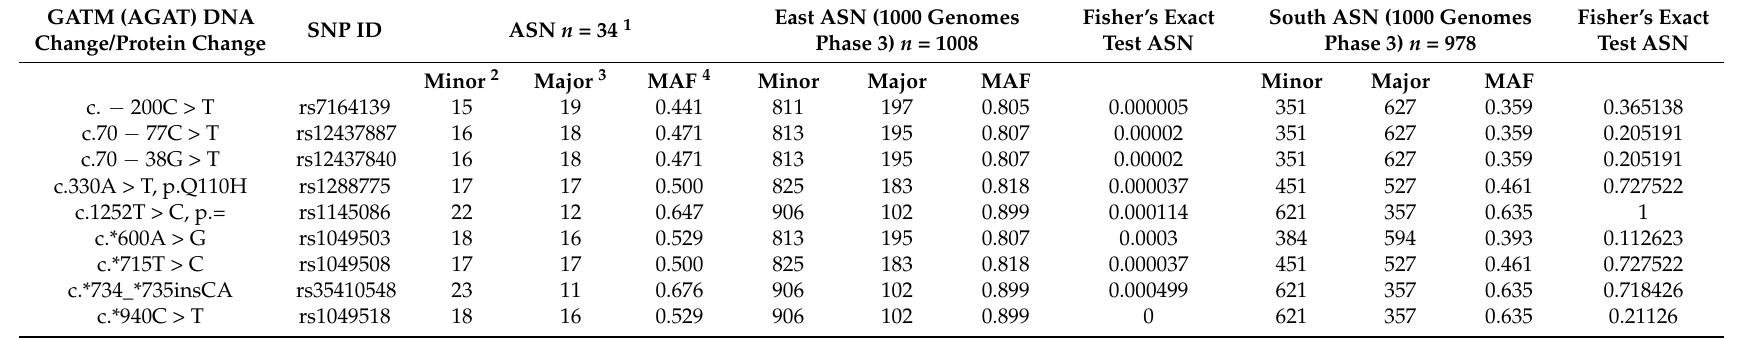
Table 4. Summary of glycine amidinotransferase ( GATM ) gene variants that showed significance when compared to East Asian population, with additional data